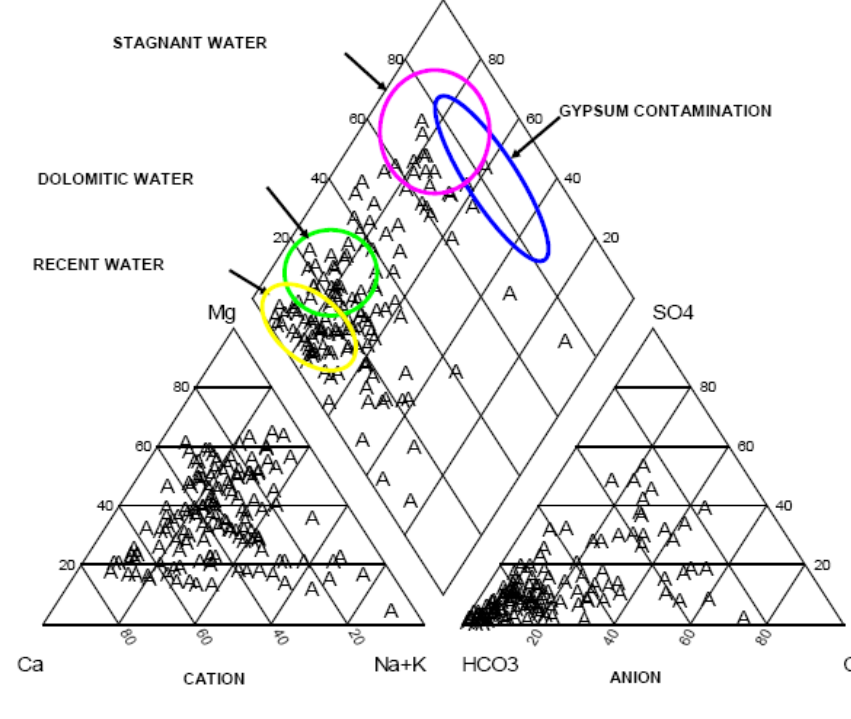
Figure 10. Piper Diagram: Chemical analyses of 138 samples within the VDWHS.